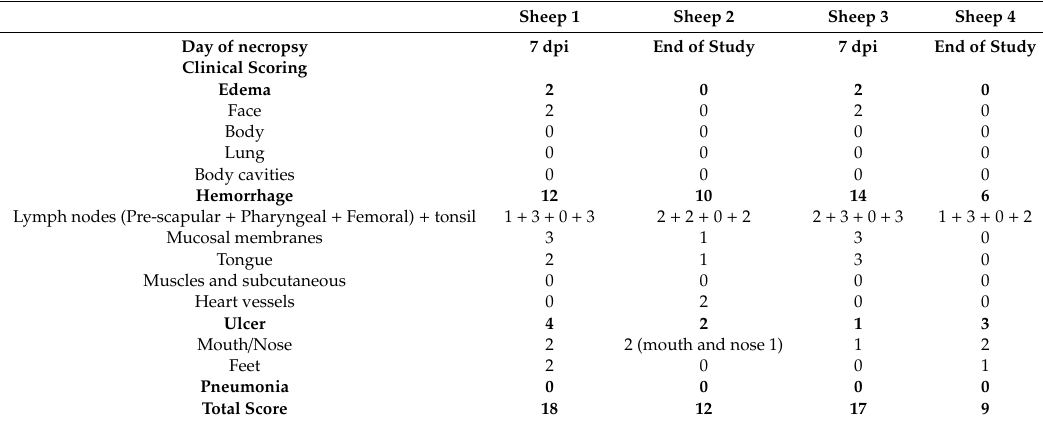
Table 2. Pathology score of all sheep at time point of euthanasia. Sheep 1 and 3 were euthanized as they exceeded clinical limits for the study at day 7 post-infection with bluetongue virus (BTV). Clinical signs exhibited by sheep 2 and 4 were observed to the end of the study (day 16 post infection with